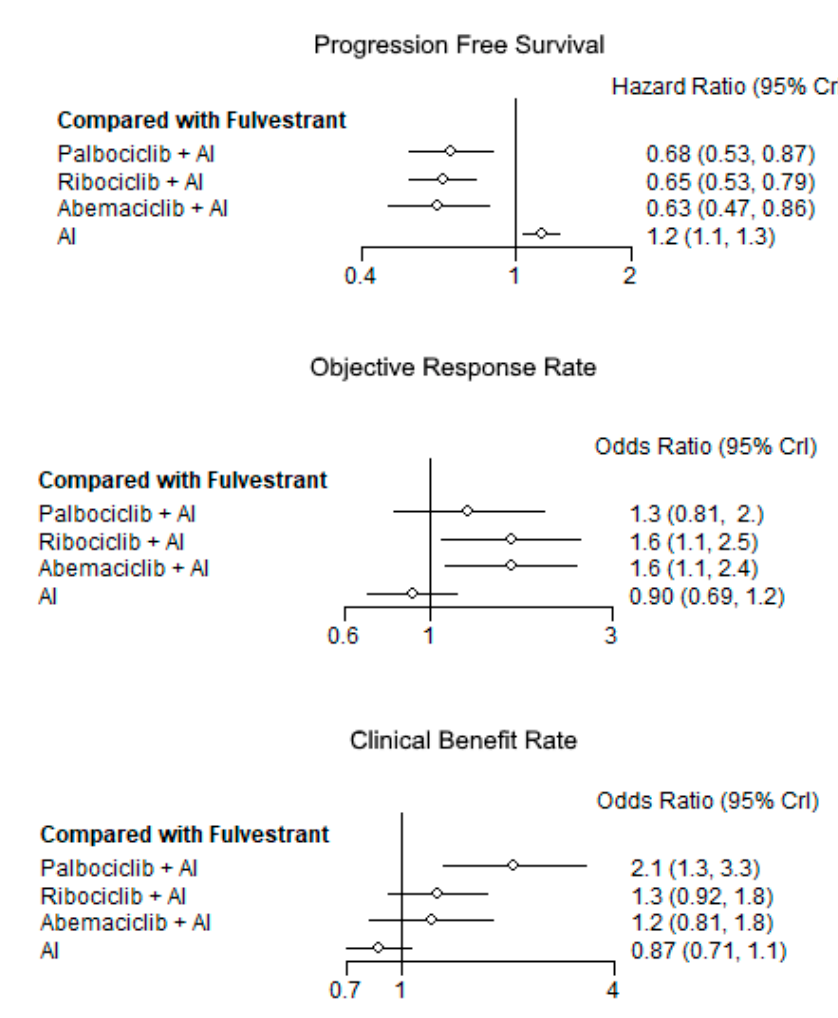
Figure 3. Forest plots with direct comparisons against fulvestrant for progression-free survival, objective response rate, and clinical benefit rate. AI: Aromatase inhibitor.